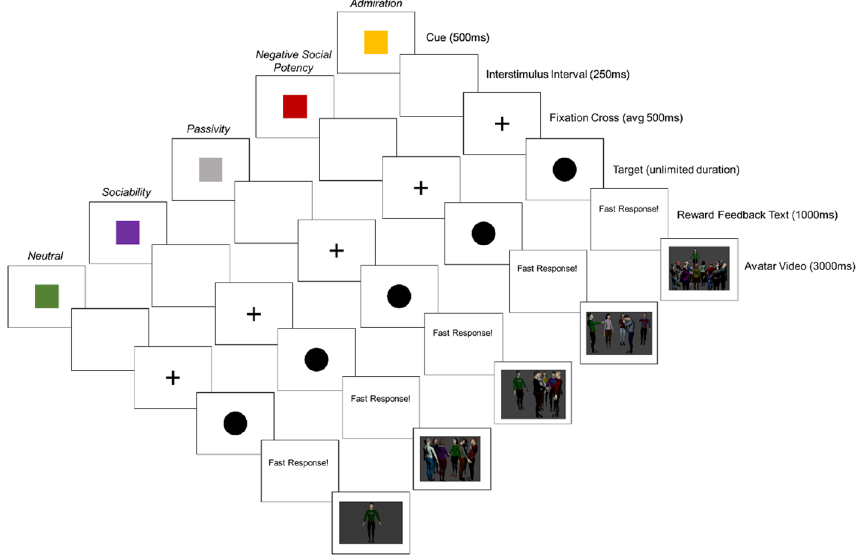
Figure 2. Social reward subtype incentive delay